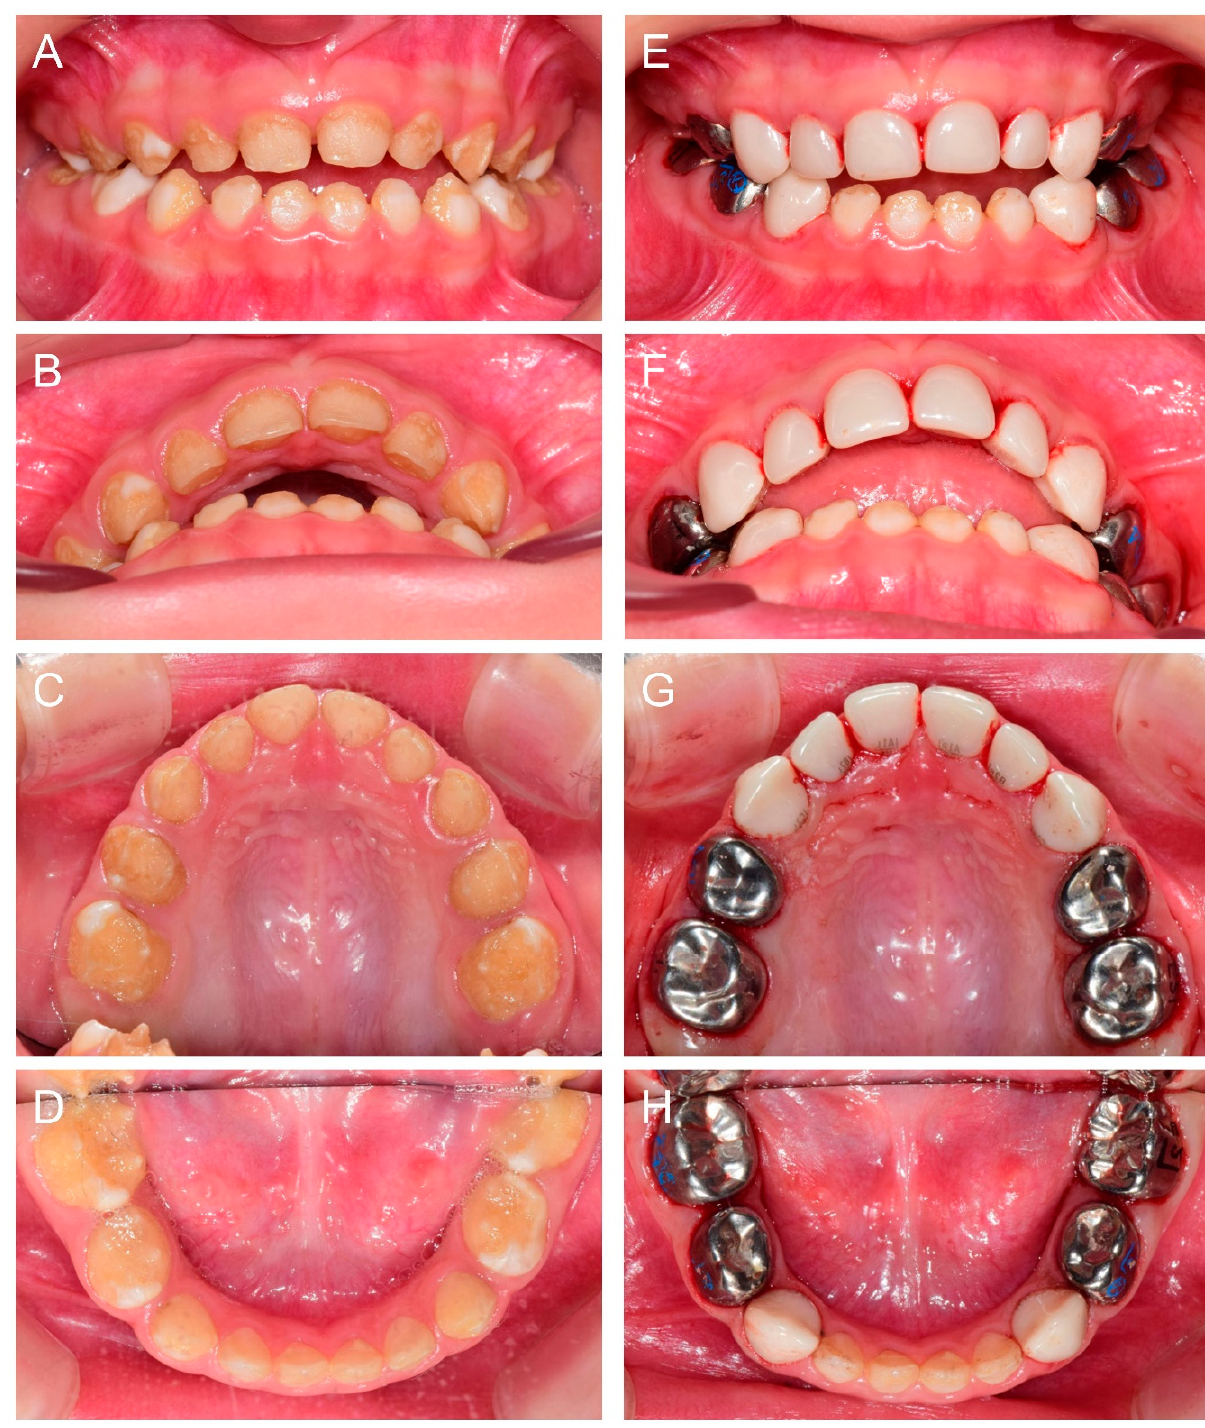
Figure 2. Clinical photos of the proband (IV:3). ( A – D ) Clinical photos of the proband before the treatment at age 2 years 9 months. ( E – H ) Clinical photos of the proband after the treatment. The deciduous molars were treated with stainless steel crowns, and the deciduous canines and maxillary anterior teeth were treated with zirconia crowns. The deciduous mandibular anterior teeth were left untreated.